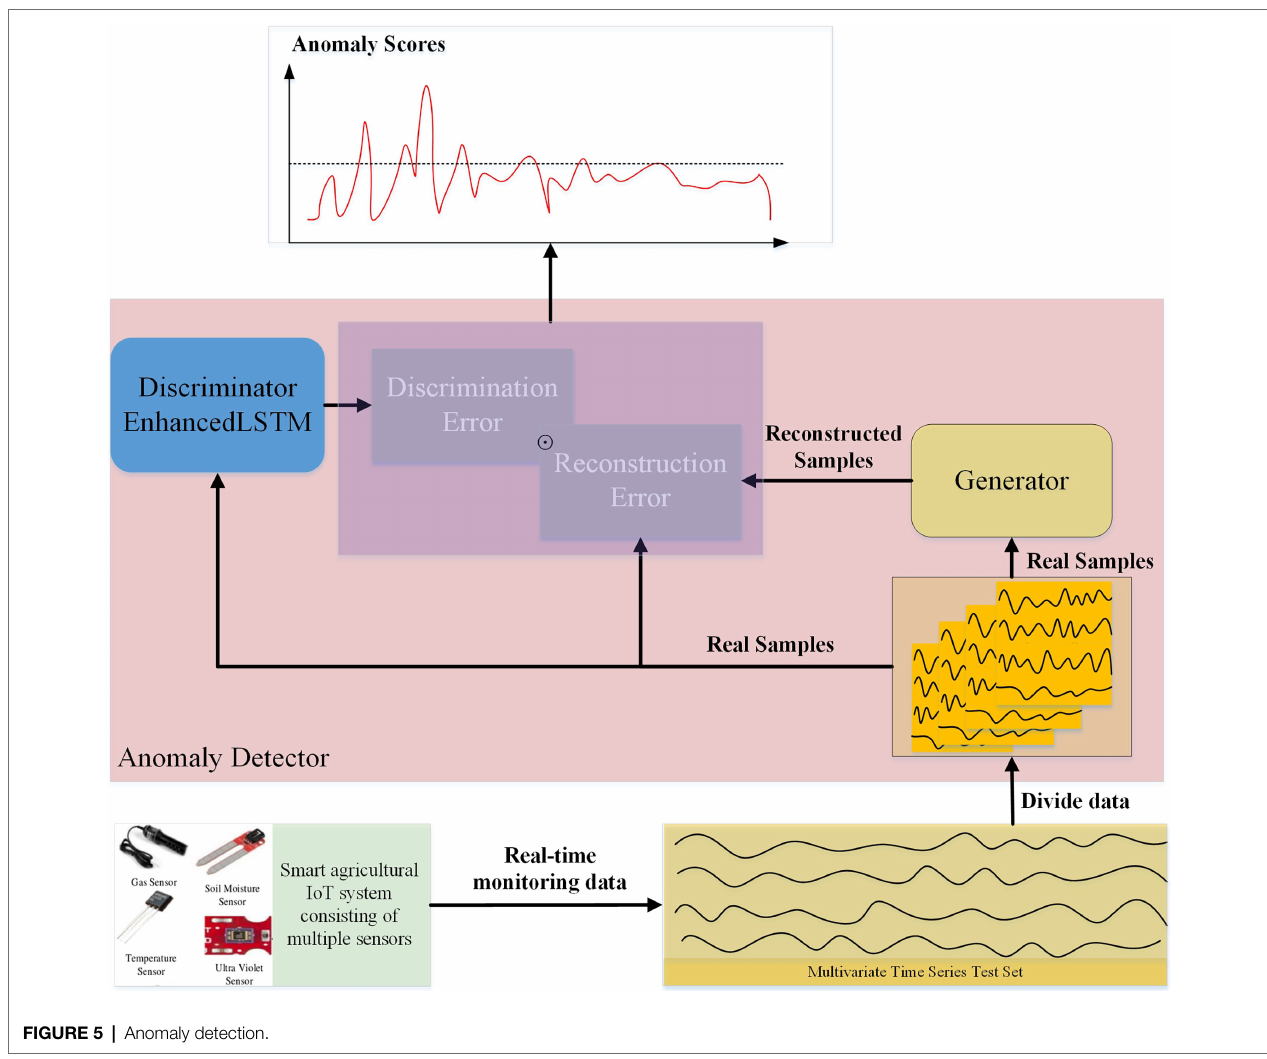
FIGURE 5 | Anomaly